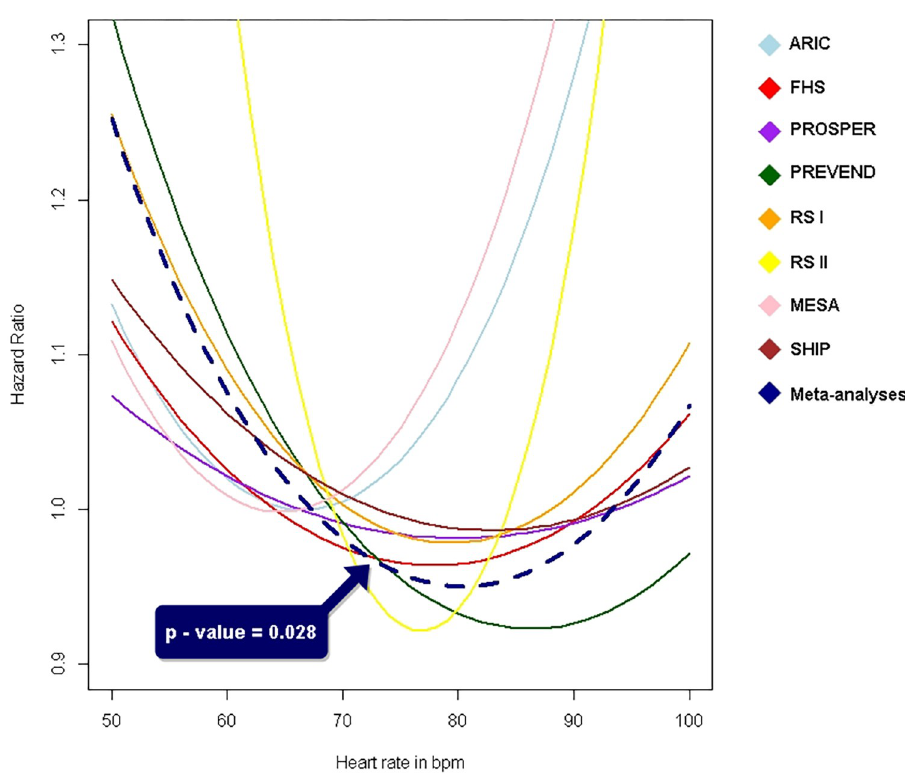
Fig 3. U-shaped association between resting heart rate and incident AF in seven cohorts of the AFGen consortium. A regression analysis using a quadratic term was performed per cohort to explore a non-linear association. The meta-analysed quadratic term of the association between resting heart rate and incident AF is significant (p-value = 0.028).